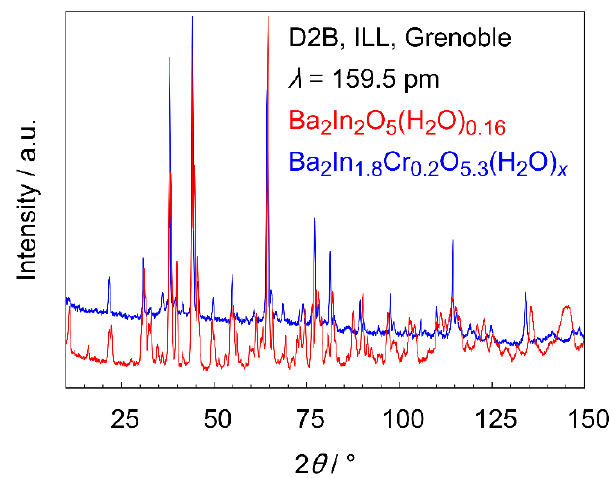
Figure 7. Comparison of the collected normalised high-resolution neutron diffraction data of Ba 2 In 2 O 5 (H 2 O) 0.16 and Ba 2 In 1.8 Cr 0.2 O 5.3 (H 2 O) x at room temperature, Numor 556649–556658 and 556720–556729, DOI: doi.org/10.5291/ILL-DATA.5-24-640. Table 3. Refined oxygen contents during the heating of Ba 2 In 1.8 Cr 0.2 O 5.3 (H 2 O) x in a dynamic vacuum ( p min ≥ 1.2 × 10 − 5 mbar) from room temperature to 1573 K at D20, ILL, Grenoble.